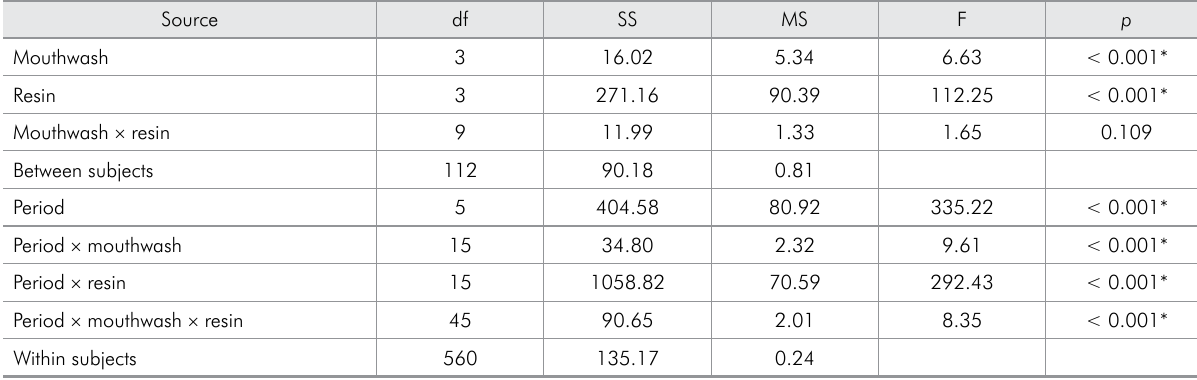
Table 3 - Three-way repeated-measures analysis of variance of acrylic resins in